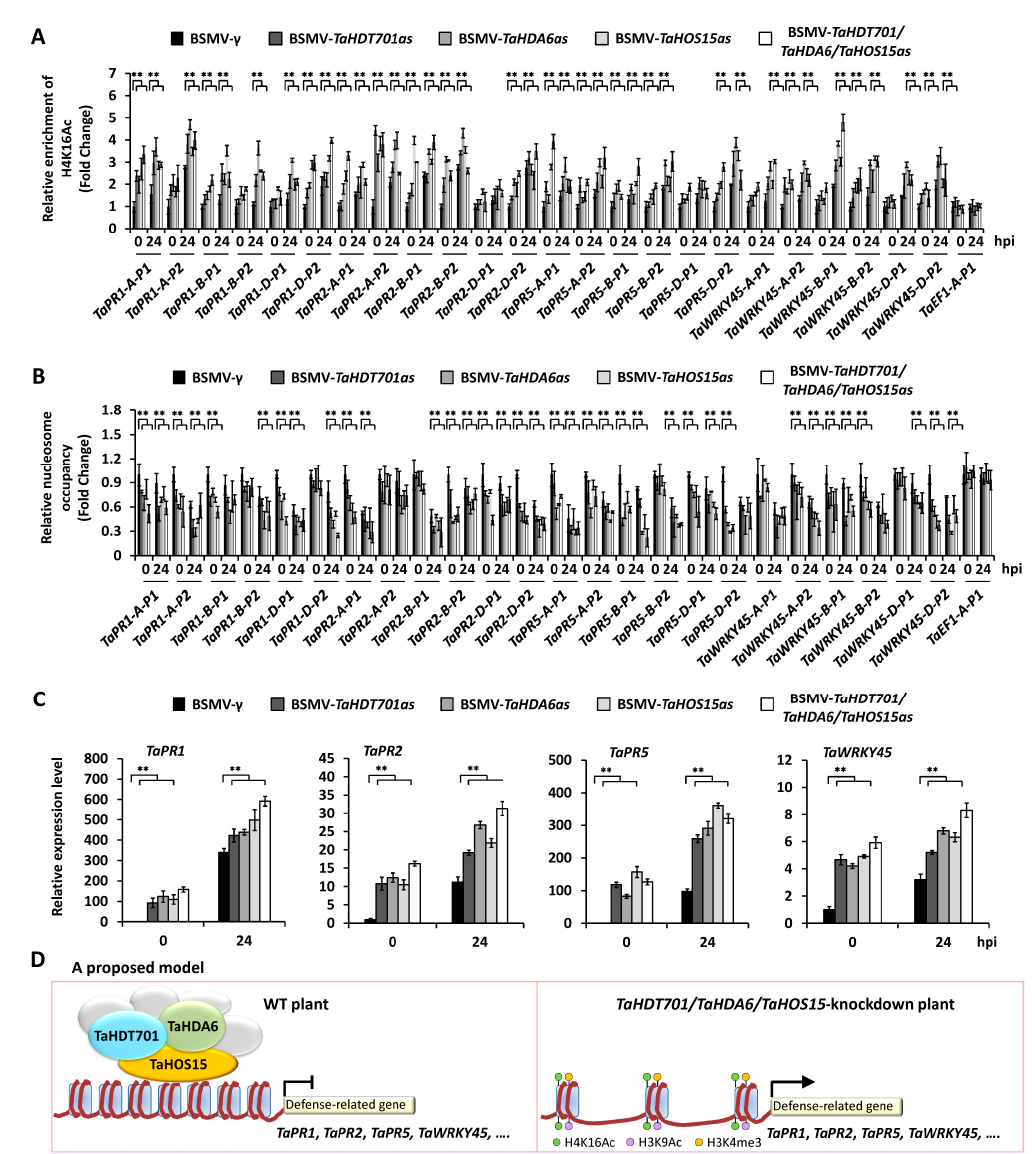
Figure 6. Silencing of TaHDT701 , TaHDA6 , and TaHOS15 affects the histone H4K16Ac, nucleosome distribution and expression levels of TaPR1 , TaPR2 , TaPR5 , and TaWRKY45 . ( A ) ChIP-qPCR analysis of H4K16Ac at the promoter regions of TaPR1 , TaPR2 , TaPR5 , and TaWRKY45 on wheat plants with different background. Antibodies α -H4K16Ac were used for immunoprecipitation. Before ChIP-qPCR analysis, the wheat leaves with a typical BMSV symptom were inoculated with Bgt conidia for 0 and 24 h. The histone acetylation level in BSMV- γ wheat leaves was set to 1.0 at 0 hpi after normalization by histone H4 ChIP. The fragments employed for ChIP-qPCR analysis are